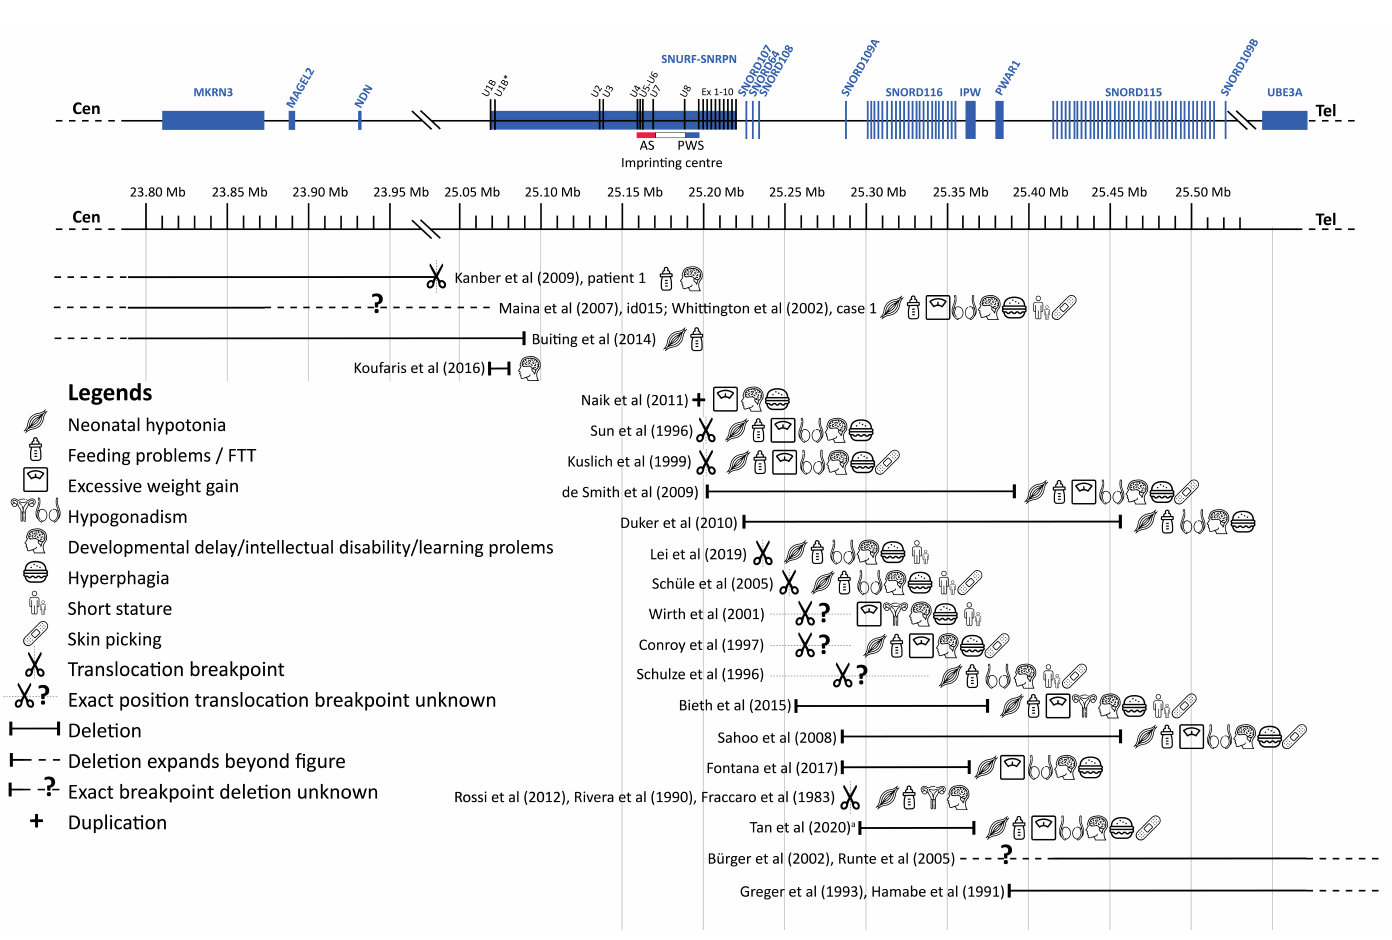
Figure 6. Overview cases literature review. Abbreviations: Angelman syndrome (AS), failure to thrive (FFT), Prader–Willi syndrome (PWS). a Exact breakpoints for this case are not available, depicted is the minimal deleted region. This figure shows an overview of the cases we found during our literature review. For each case, the affected region is depicted, followed by symbols representing the clinical phenotype of the case. Genes are represented at scale with physical distance in Mb. SnoRNAs are depicted as vertical lines and other genes as boxes. Deletions are depicted according to the genomic deletion coordinates for build hg19. Excessive weight gain was only scored as present if it occurred when the case was 1 to 6 years old. Figure adapted from Fontana et al. [19] and Tan et al. [13]. This figure has been designed using resources from Flaticon.com (from surang, freepik, smashicons, dinosoftlabs and monkik), accessed on 1 March 2021.